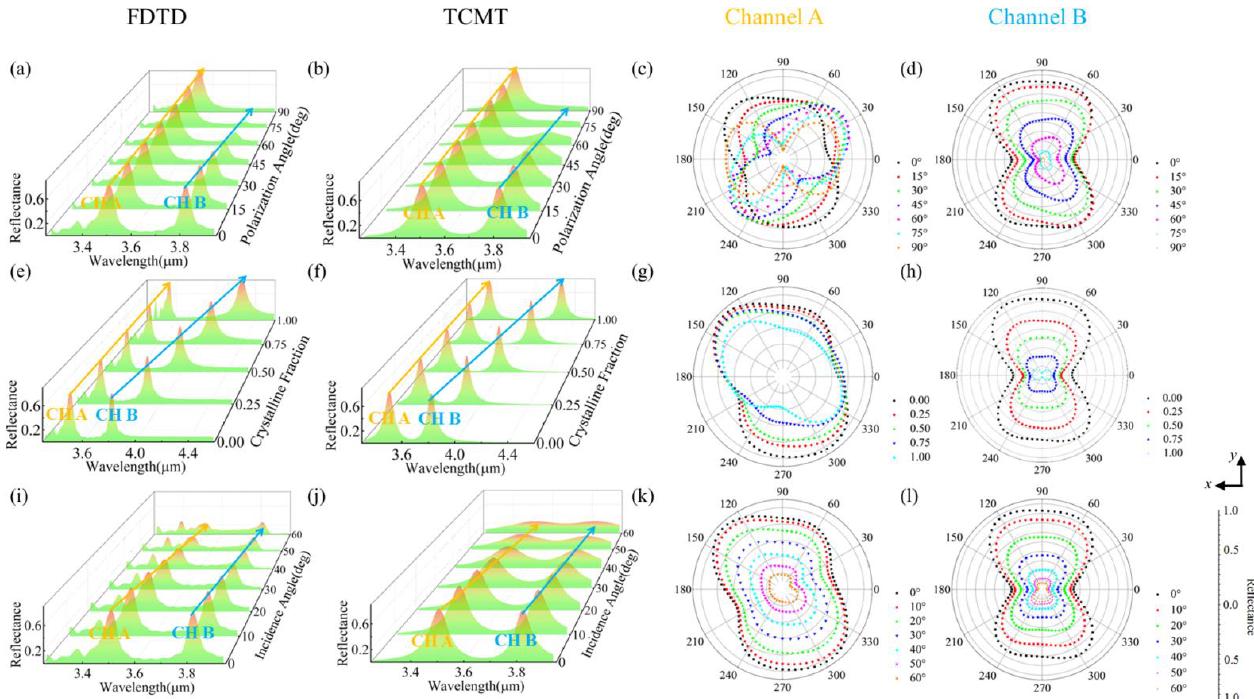
Figure 4. ( a ) Reflectance spectra with different polarization angles of incident light; ( b ) reflectance spectra with different polarization angles of incident light calculated by TCMT; ( c ) far-field scattering patterns in X-Y plane of channel A with different polarization angles; ( d ) far-field scattering patterns in X-Y plane of channel B with different polarization angles; ( e ) reflectance spectra with different crystalline fractions of GST; ( f ) reflectance spectra with different crystalline fractions of GST calculated by TCMT; ( g ) far-field scattering patterns of channel A in X-Y plane with different crystalline fractions; ( h ) far-field scattering patterns of channel B in X-Y plane with different crystalline fractions; ( i ) reflectance spectra with different incidence angle θ ; ( j ) reflectance spectra with different incidence angle θ calculated by TCMT; ( k ) far-field scattering patterns in X-Y plane of channel A with different incidence angle θ ; ( l ) far-field scattering patterns in X-Y plane of channel B with different incidence angle θ .